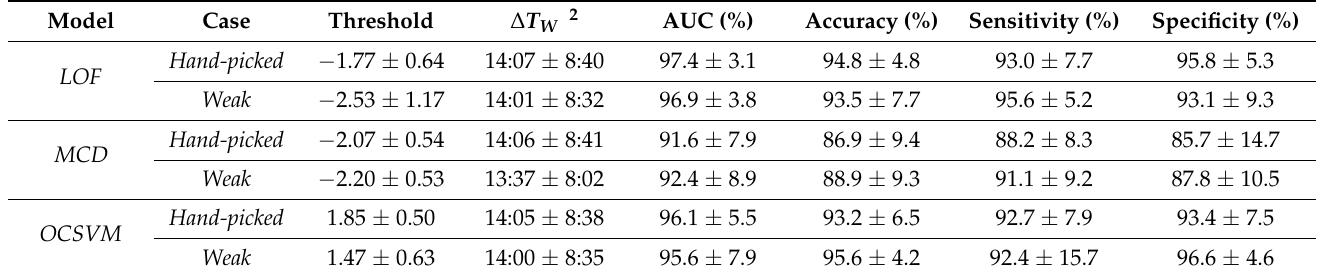
Table 4. Average model performance (mean ± std) across all PIHROPE 1 .